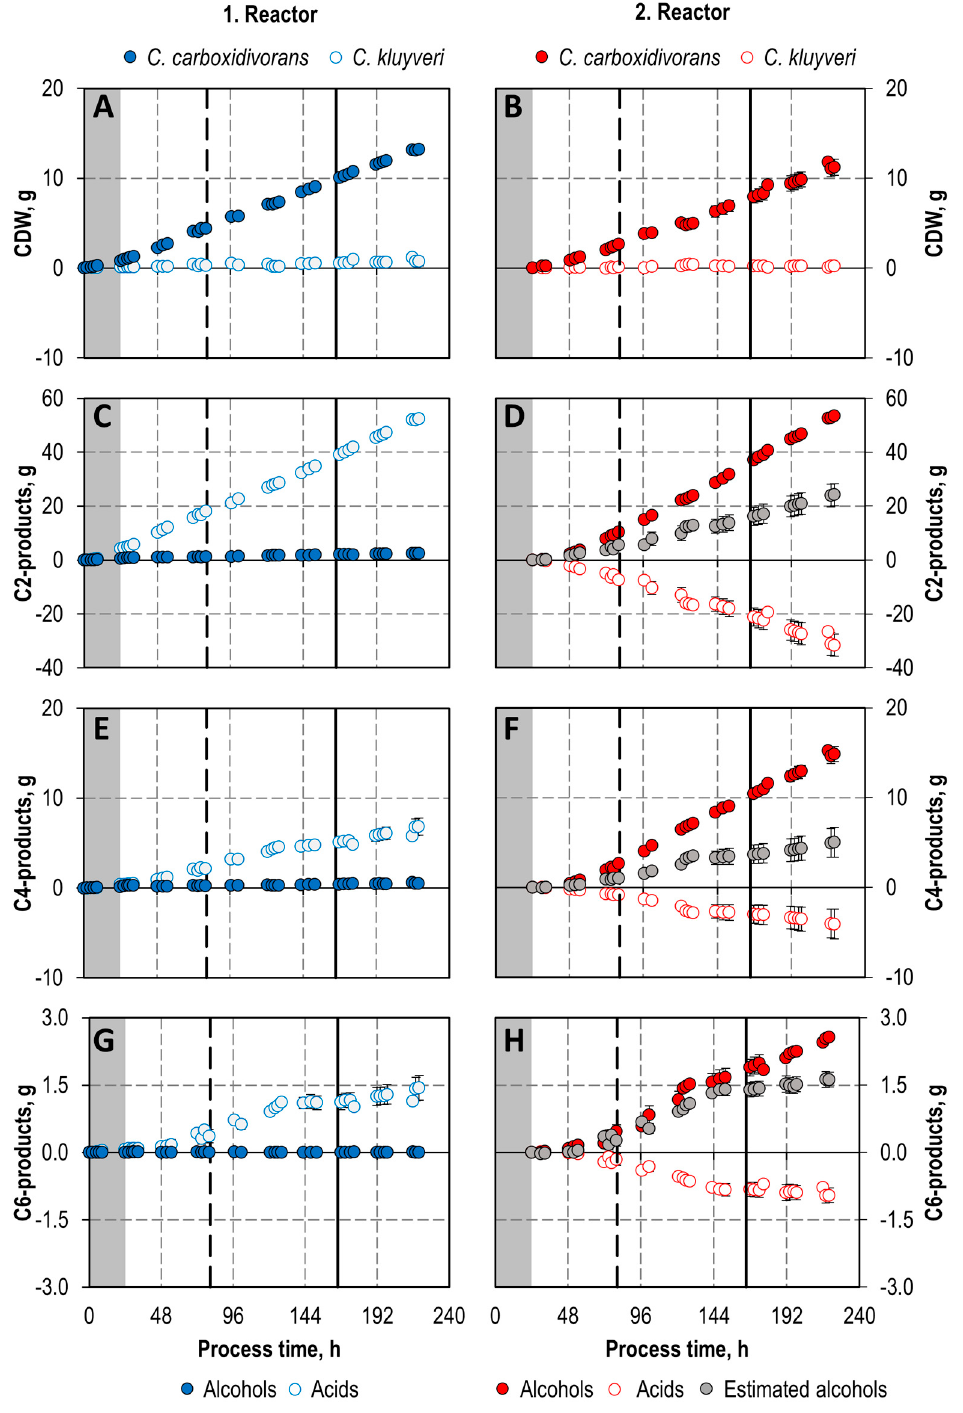
Figure 7. Cumulative production/consumption of cells (( A ): CDW of the 1. Reactor; ( B ): CDW of the second reactor) and products (( C , E , G ): C2,C4 and C6 products of the first reactor; ( D , F , H ): C2,C4 and C6 products of the second reactor) during autotrophic co-cultivation of C. carboxidivorans and C. kluyveri in a continuously operated stirred-tank bioreactor cascade with a dilution rate of 0.09 h − 1 in the first reactor and 0.06 h − 1 in the second reactor (P = 1 bar, T = 37 ◦ C, pCO 2,in = 200 mbar CO 2 ). First reactor (blue): pH 6.0, p CO,in = 100 mbar, F gas = 0.042 vvm, 0.05 mM S L − 1 h − 1 ; second reactor (red): pH 5.0, p CO,in = 800 mbar, F gas = 0.083 vvm. Alcohols (ethanol, 1-butanol, 1-hexanol) as well as CDW of C. carboxidivorans are shown in full circles; acids (acetate, butyrate, hexanoate) as well as CDW of C. kluyveri are shown in open circles. Grey symbols show the estimated production of alcohols if the